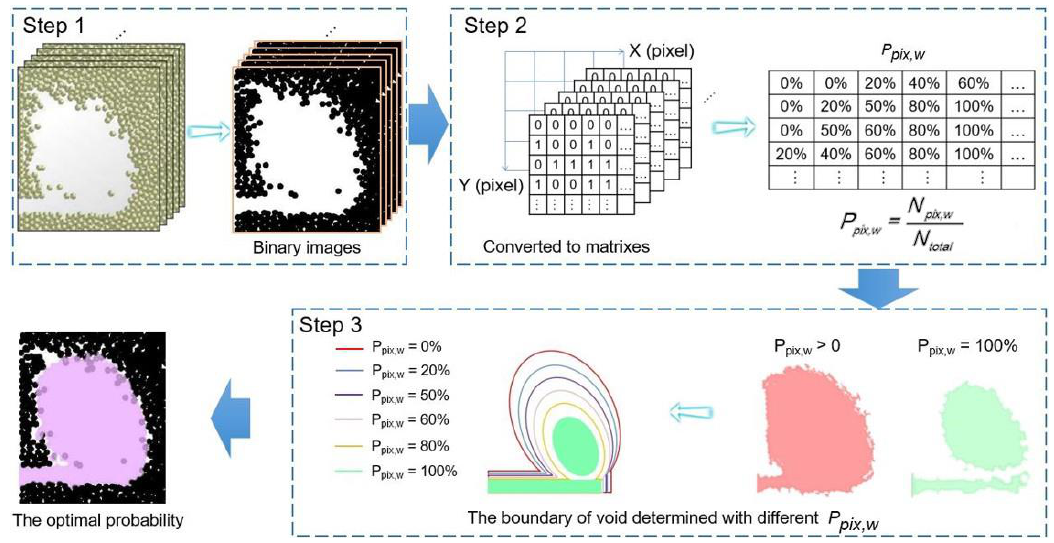
Figure 2. Probability method steps.